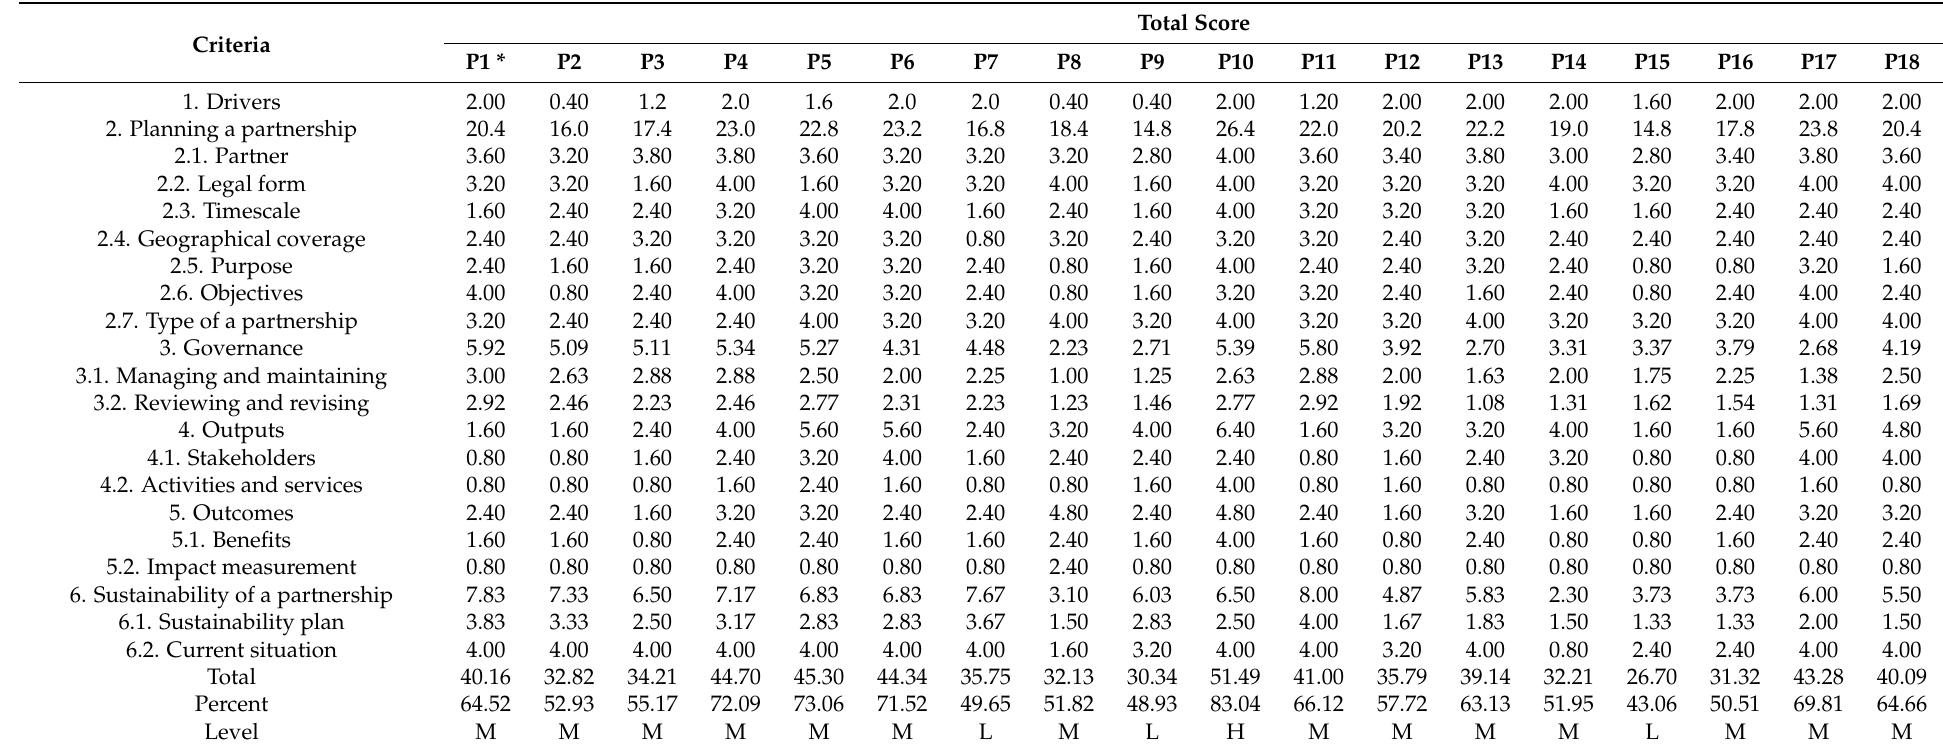
Table 13. Total score for the strength of the